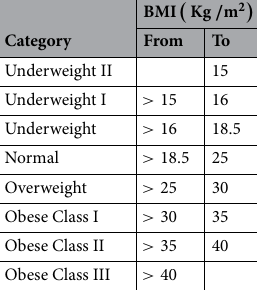
Table 2. Histogram of BMI and body mass index (BMI) classification.